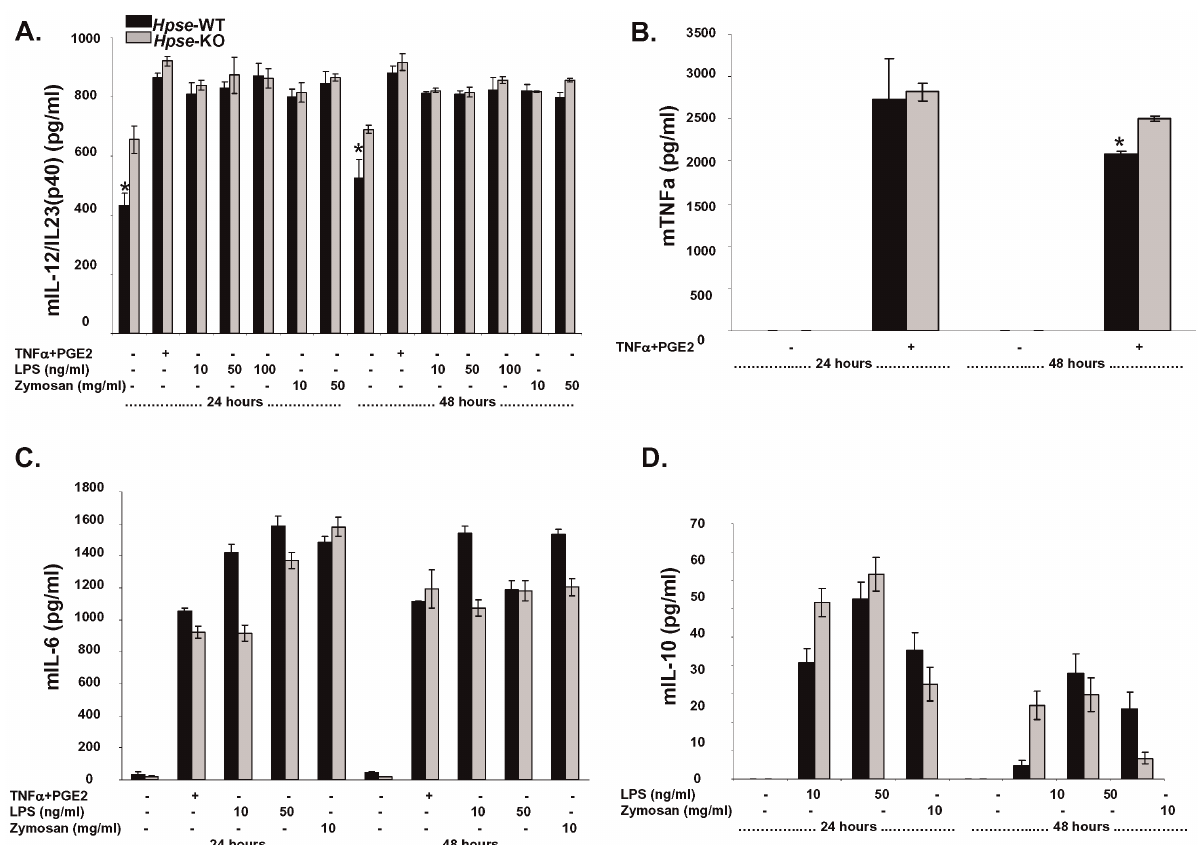
Figure 4. Cytokine secretion from iDCs and mDCs is comparable in DCs from Hpse -WT and Hpse -KO mice. A , B , C and D . Following DC maturation, supernatant culture was collected and analyzed by ELISA for ( A ) murine IL-12/IL-23(p40), ( B ) murine TNF a ( C ) murine IL-6, and ( D ) murine IL-10 production. Asterisk indicates p , 0.02, t-test.